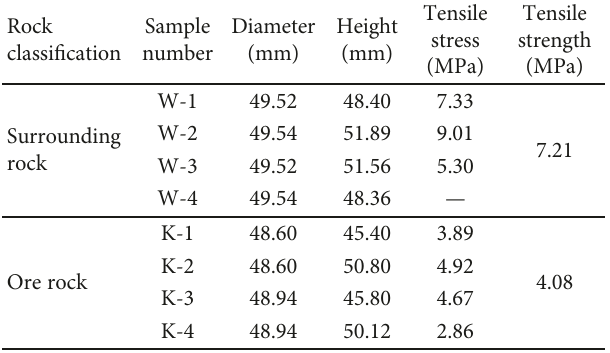
Table 2: Parameters and results of the tensile strength test specimen. Rock